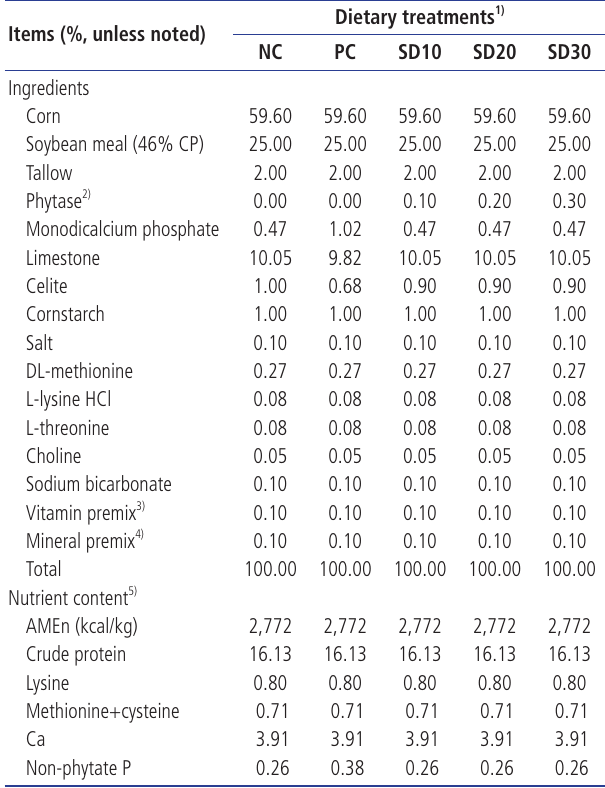
Dietary treatments